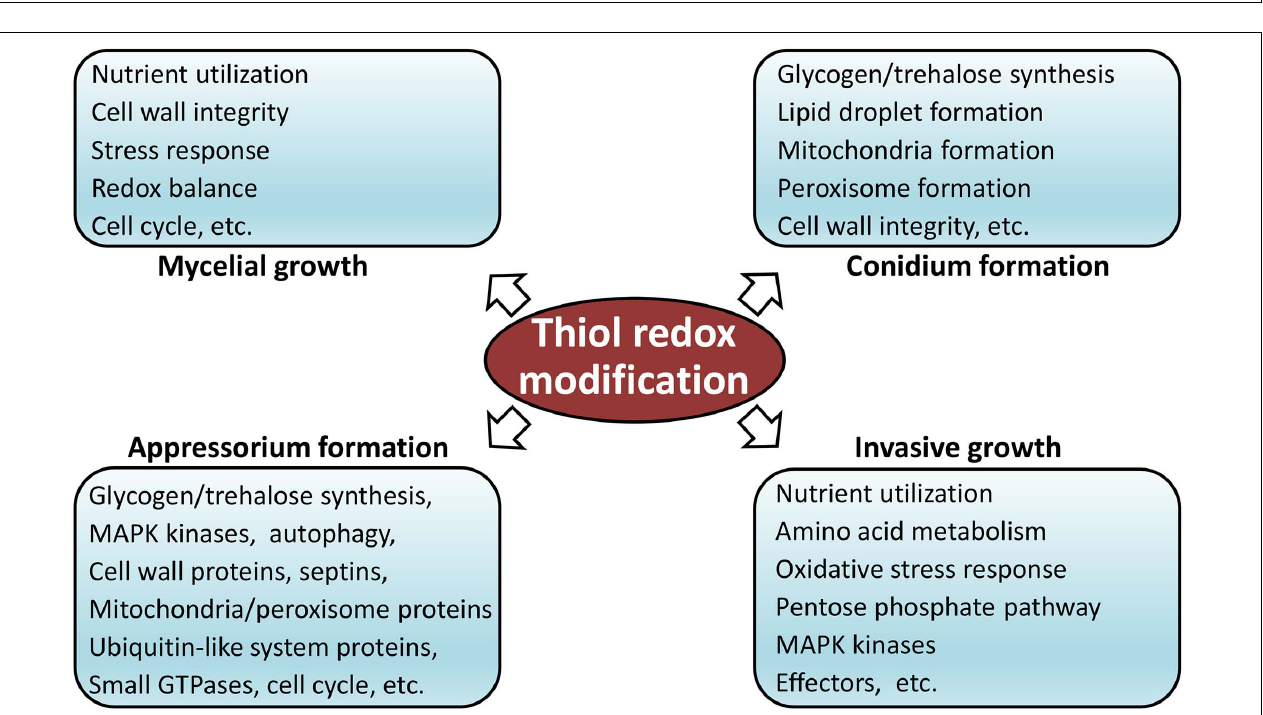
FIGURE 4 | Metabolic pathway and protein–protein interaction analyses of the thiol proteins. (A) Kyoto Encyclopedia of Genes and Genomes (KEGG) pathway enrichment bubble plot of the identified thiol proteins. (B) STRING network analysis of identified thiol proteins.